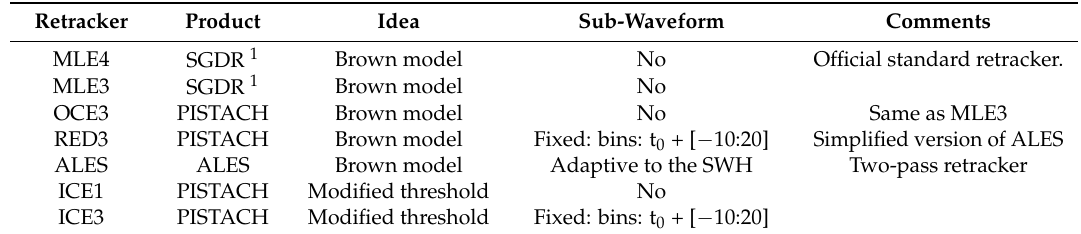
Table 1. Overview of different retrackers applied in different altimetry